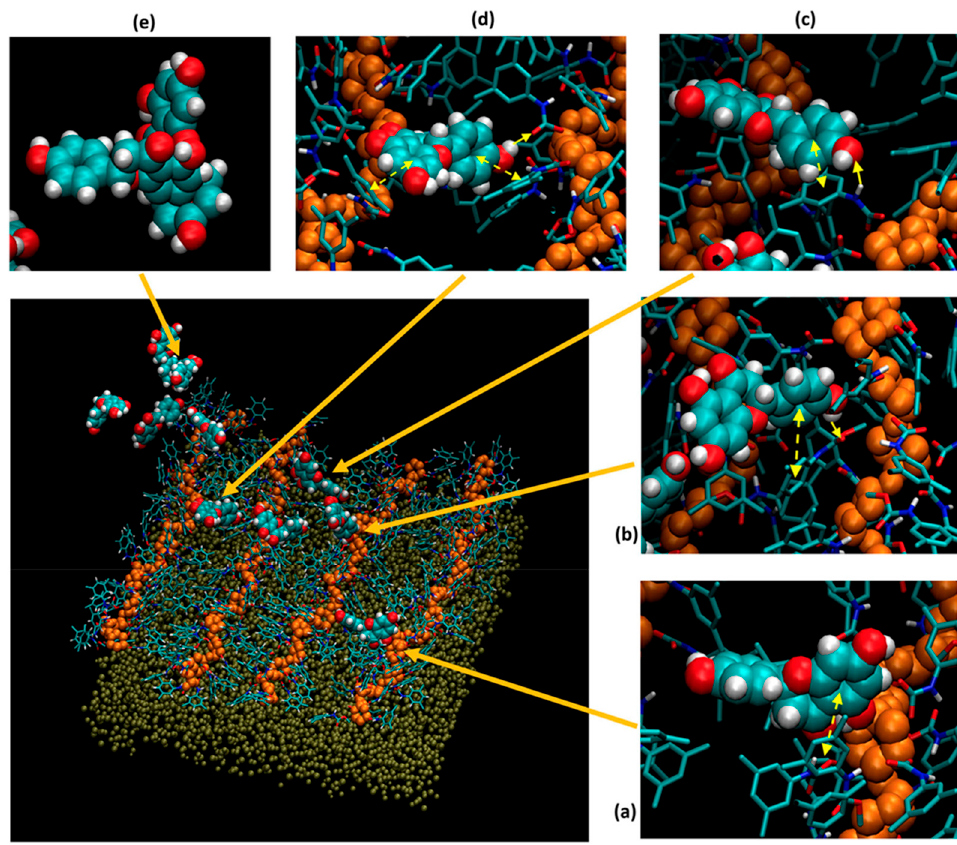
Figure 5. A snapshot of naringenin interacting with ADMPC polymers on amorphous silica slab. Insets ( a )–( e ) are zoom-in looks at individual naringenin molecules interacting with the polymer strands, or in a fairly rare event, forming a dimer. [Reprinted with permission from [112]].